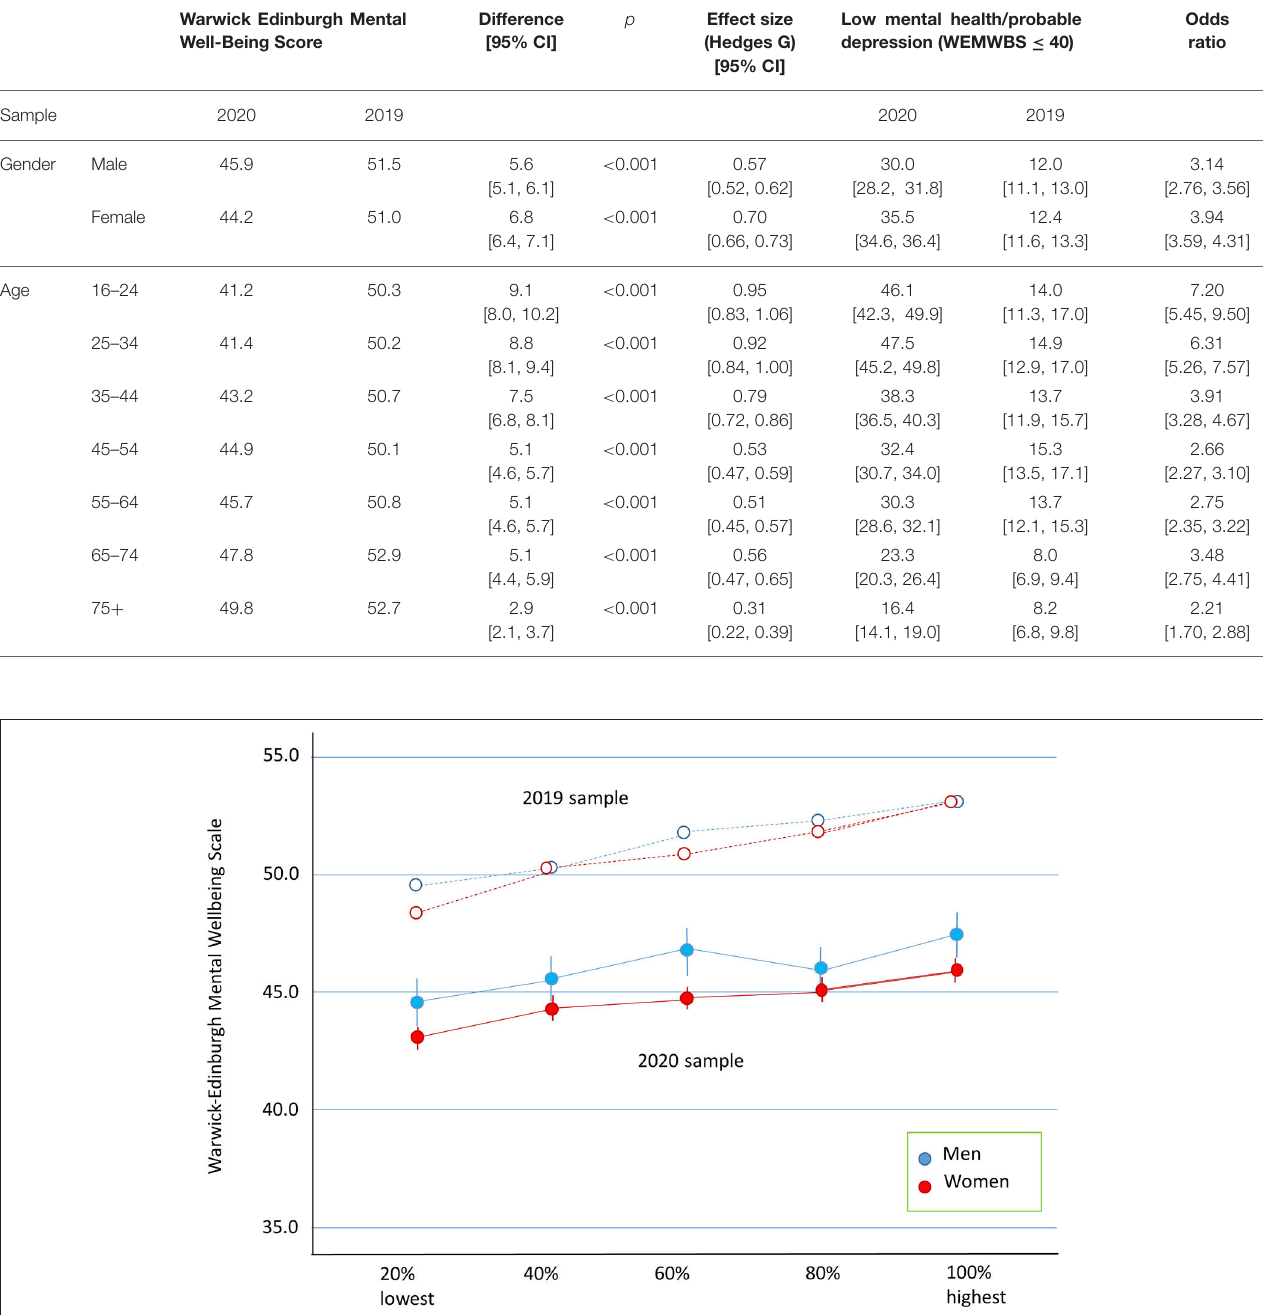
TABLE 2 | Results from the Warwick-Edinburgh Mental Wellbeing Scale. Numbers in square brackets represent 95% confidence intervals. Warwick Edinburgh Mental Well-Being Score